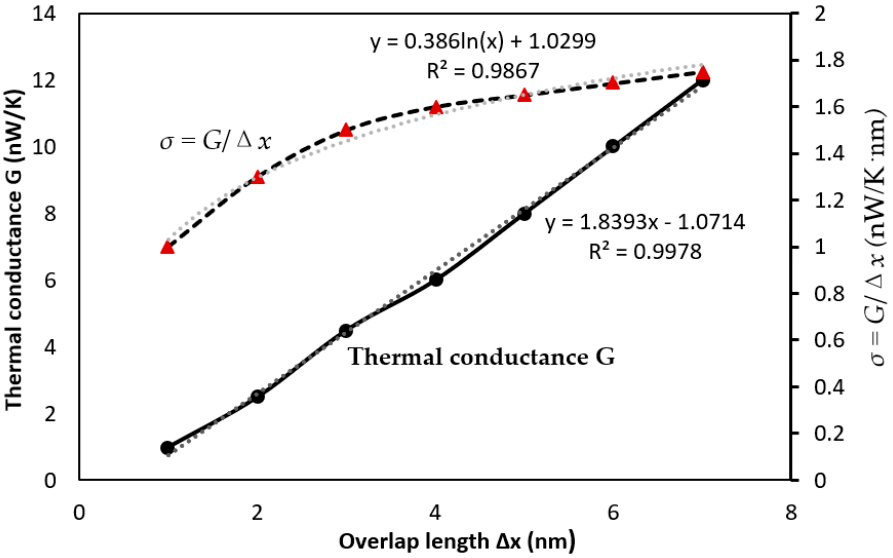
Figure 7. Thermal conductance G, and thermal conductance per unit overlap length σ as a function of overlap length Δ x. Table 3. Measured electric resistivities and conductivities of polyurethane and polycrylic-based coatings containing 4.5%wt CNTs nanocomposites, with or without H 2 O [86]. Base